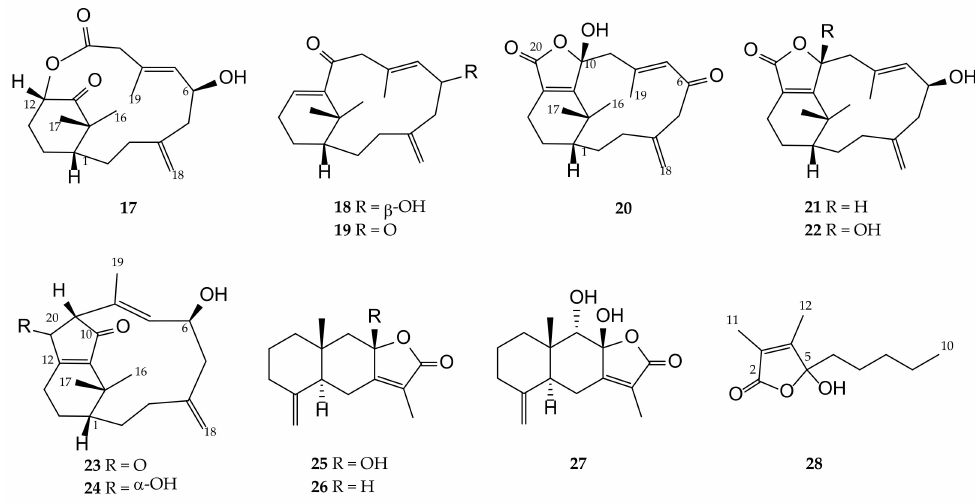
Figure 2. Structures of known compounds 17 – 28 .